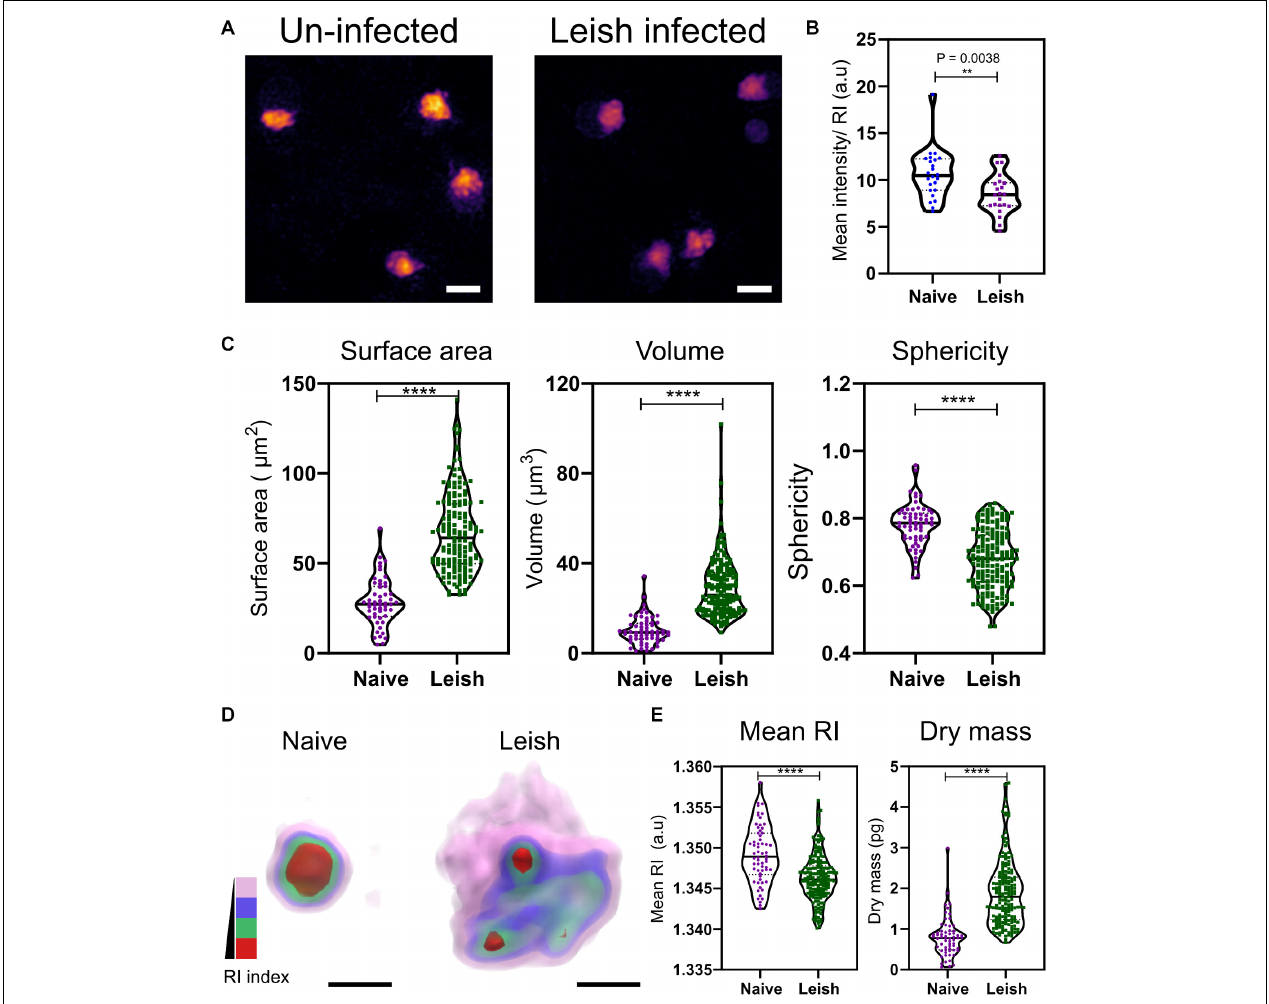
FIGURE 3 | Morphological and biophysical differences in platelets from naïve and Leishmania infected mice. (A,B) Max RI projections of the 3D phase images of platelets from Naïve and L. donovani infected mice n = 23 platelets. (C) Morphological changes seen in platelets in surface area, volume, and sphericity. n = 62 platelets, 10 platelets from each WT mice in study (6 mice) and n = 172 platelets from 17 L. donovani infected mice, median represented by black line in the violin plot. Scale bar 2 µ m. (D) 3D rendered iso-surface image of platelets from naïve and L. donovani infected mice based on RI. Scale bar 1 µ m. (E) Changes in mean RI (unpaired two-tailed t -test, P ≤ 0.0001), and dry mass (unpaired two-tailed t -test, P ≤ 0.0001) of the platelets. RI index scales; Pink: 1.3406–1.3525, blue: 1.3525–1.3621, green: 1.3622–1.3735, red: 1.3736–1.3822. ** P ≤ 0.01, **** P ≤